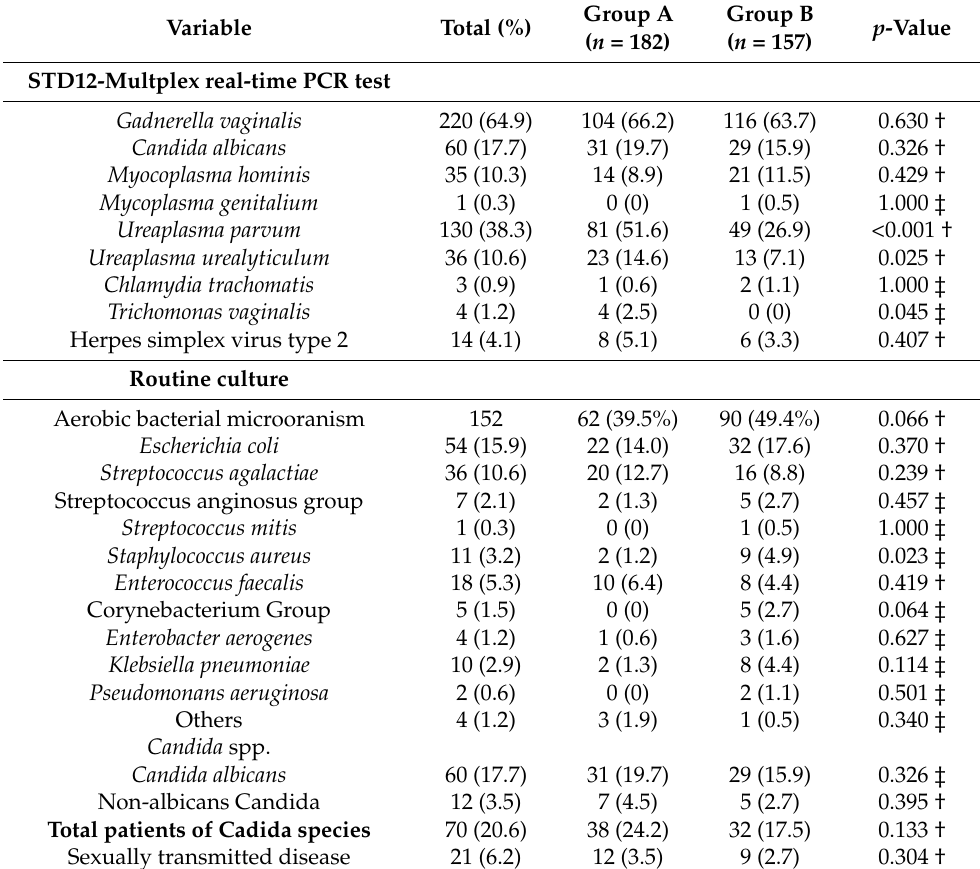
Table 2. Distribution of various pathogens and other microorganisms as identified using both